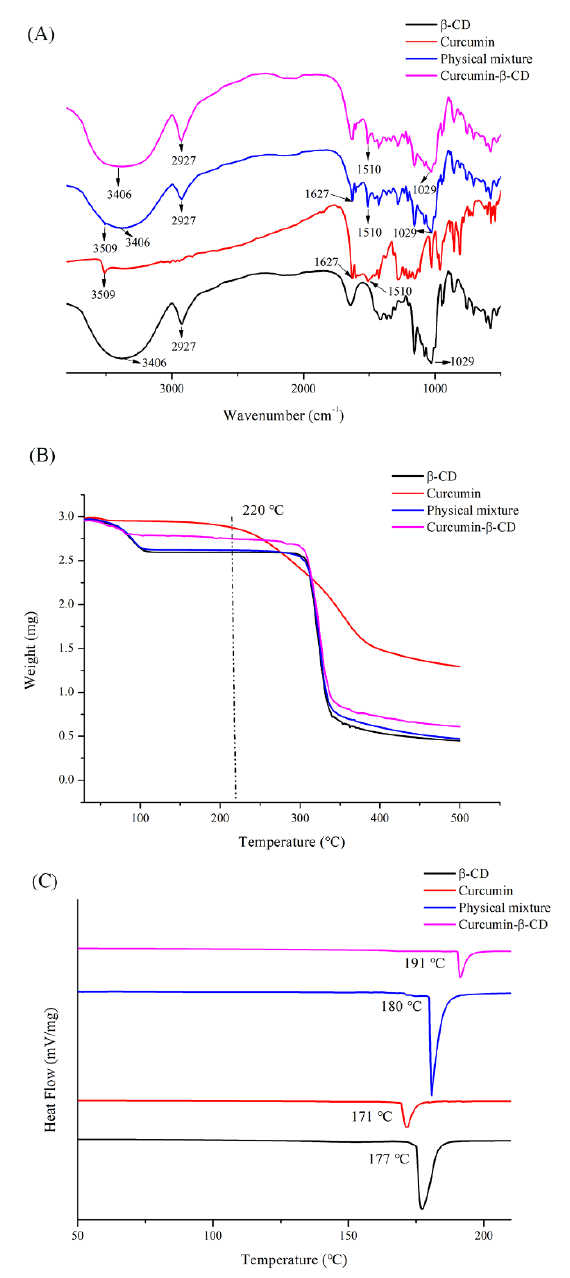
Figure 3. The characterization of curcumin, β -CD, physical curcumin and β -CD mixture, and curcumin- β -CD complex by ( A ) FT-IR, ( B ) TGA, and ( C ) DSC.